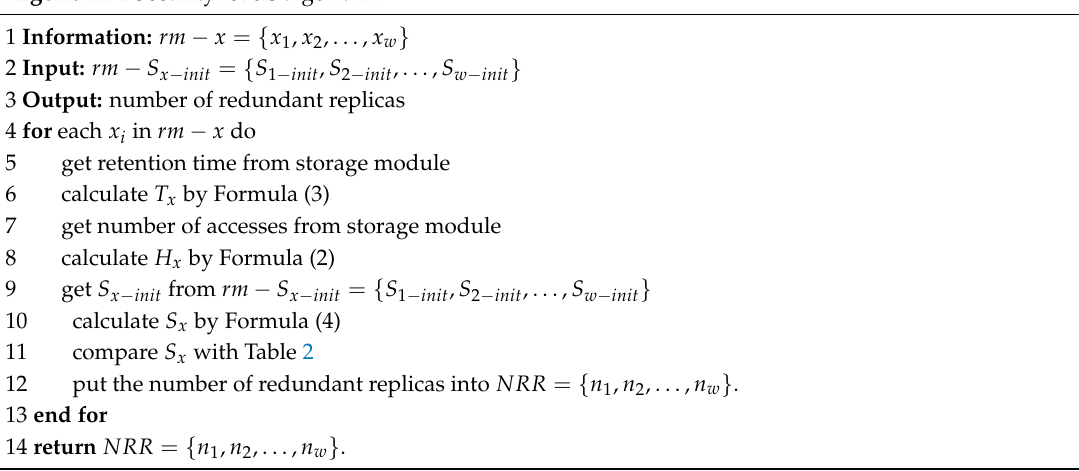
Algorithm 1 Security levels